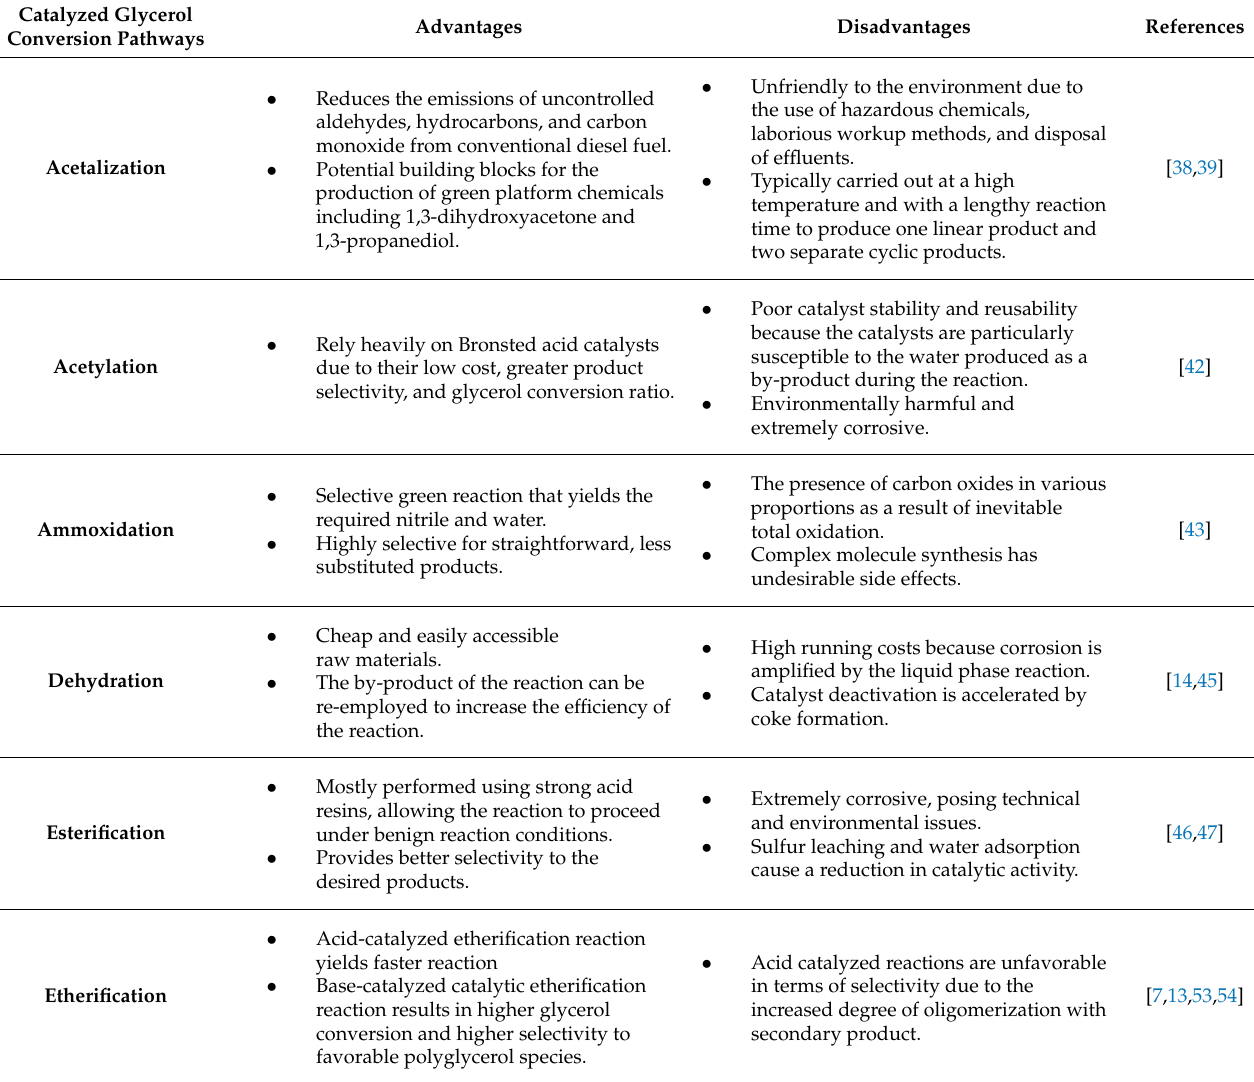
Table 1. Advantages and disadvantages of catalyzed glycerol conversion